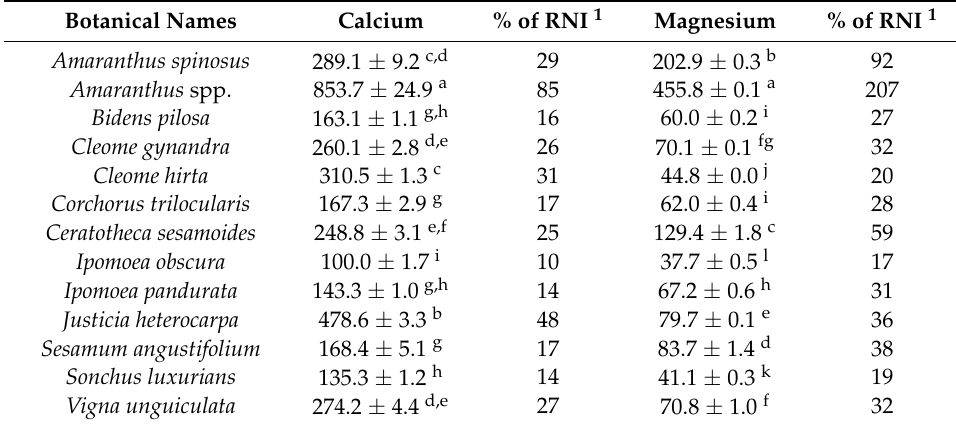
Table 5. Calcium and magnesium (mg/100 g fresh weight) of ILVs